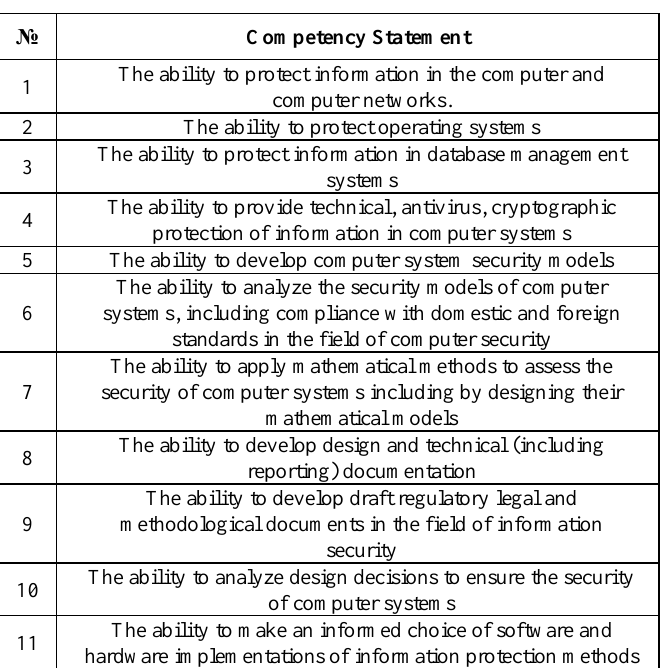
Table 1. Competency